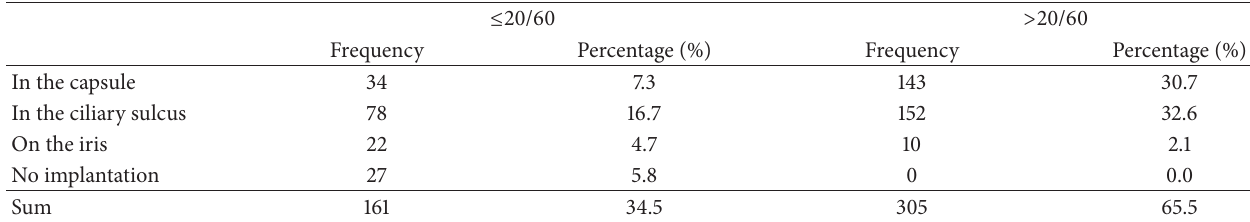
Table 5: Final VA of patients with four different IOL implantation procedures.